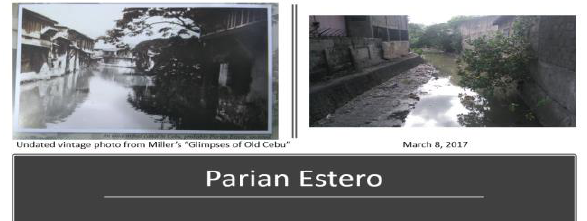
Figure 20. Left - Georectified 1890 map of Naga City, Bicol Province courtesy of the National Archives of the Philippines. Right - same area in Google Map.